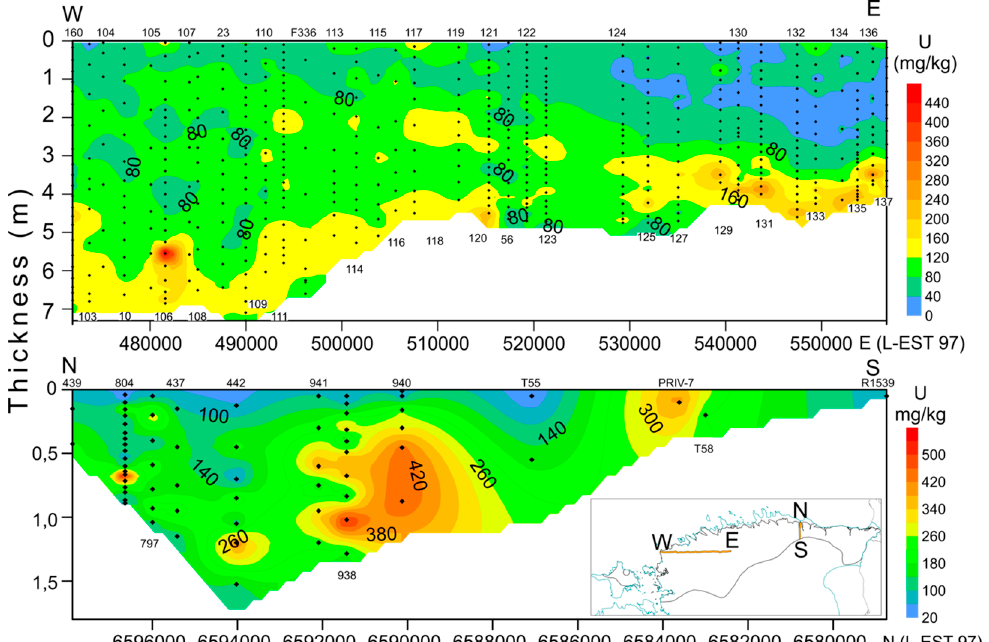
Figure 12. West–East and North–South geochemical profiles across the graptolite argillite area of Estonia. Dots indicate samples. Note the large heterogeneity of uranium concentrations.